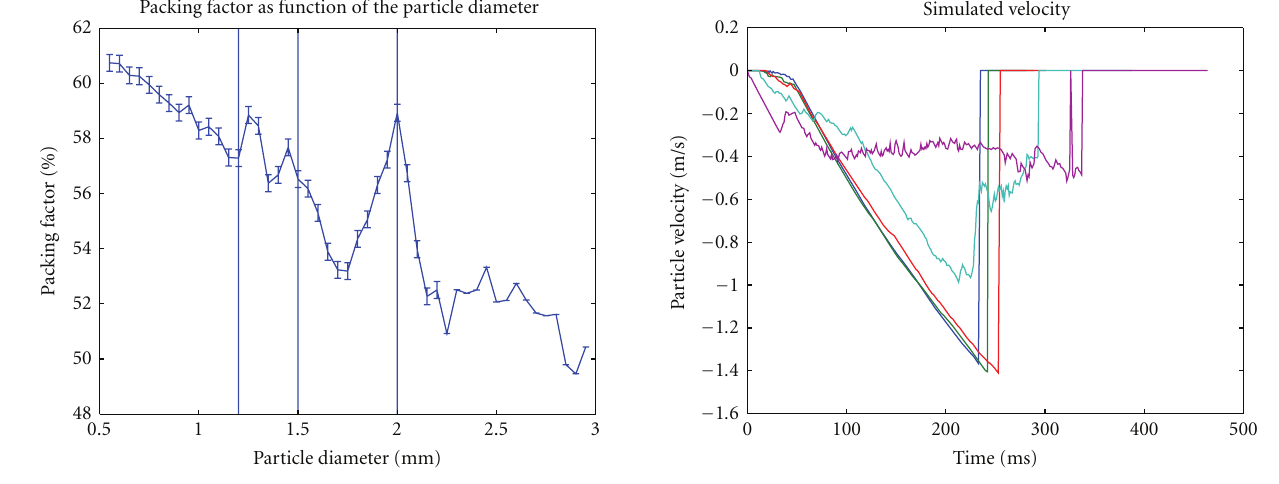
Figure 7: Packing factor of the particles in the tube as function of the particle diameter.